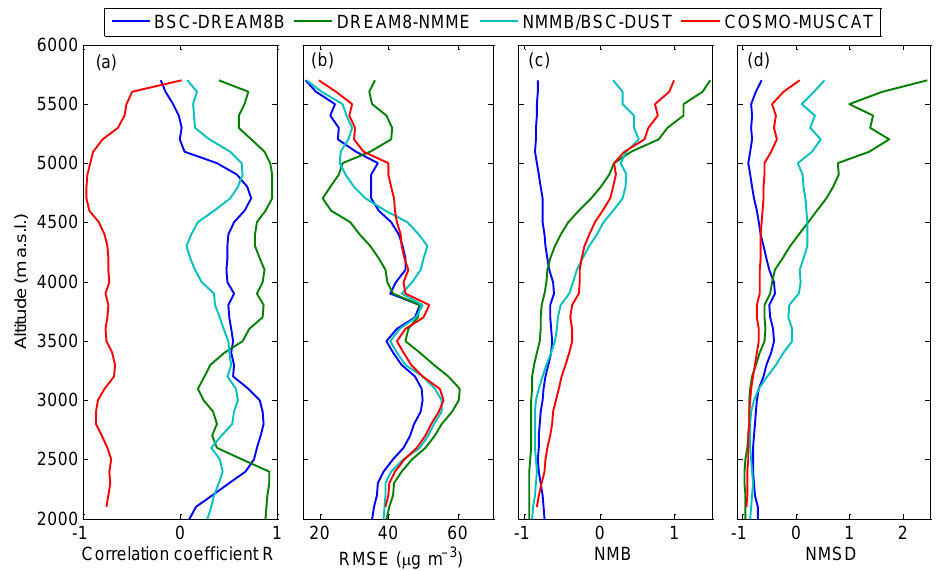
Figure 13. Vertical profiles of the correlation coefficient between LIRIC and the model time series for every altitude level, the root mean square error RMSE, the normalized mean bias NMB, and the normalized mean standard deviation